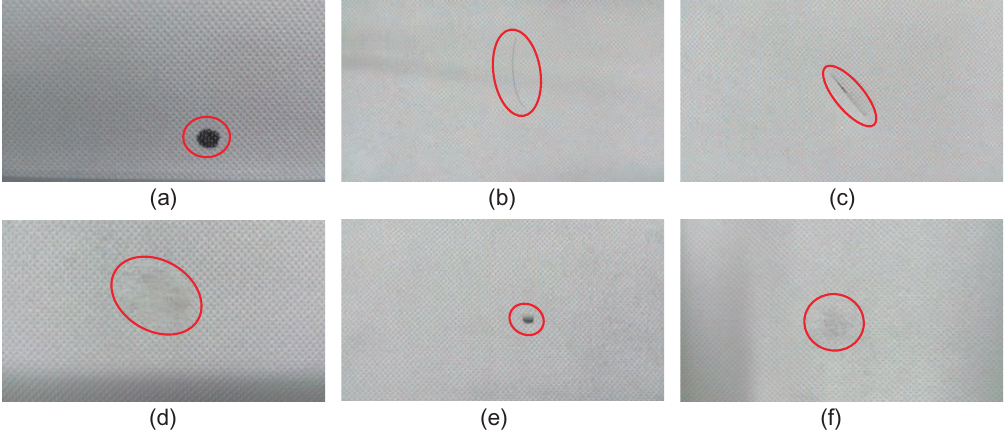
Figure 3. Different types of defects in cotton fabric; from ( a ) to ( f ), the defects are classified as oil polluted, heterozygous, scratched, flying-fiber, perforated and gauzy